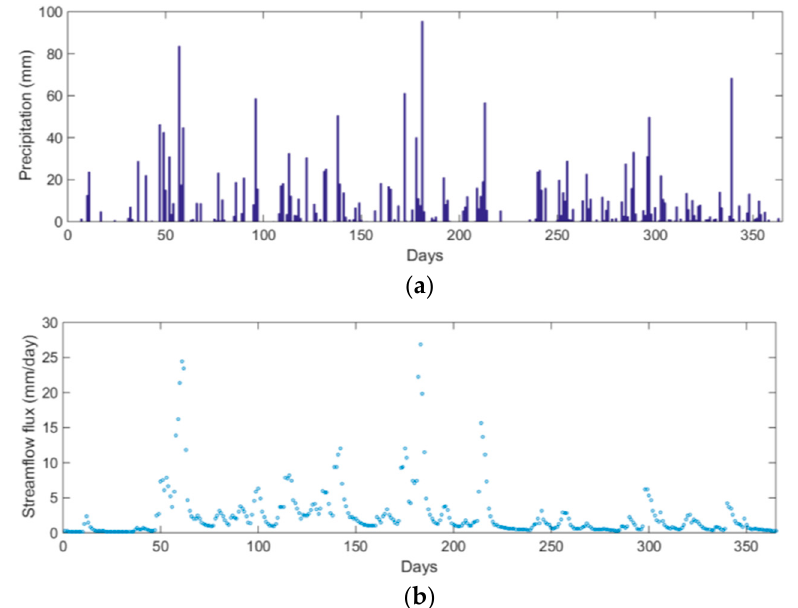
Figure 4. Measurements in the Leaf River basin: ( a ) daily hyetograph; and ( b ) hydrograph.